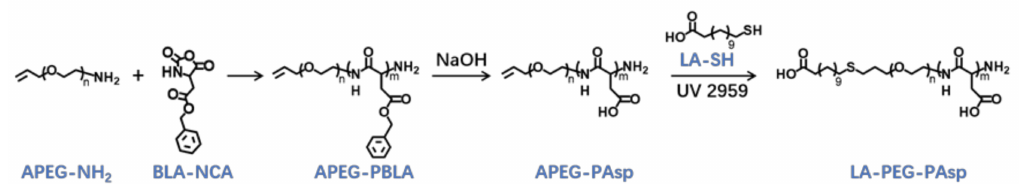
Figure 9. Synthetic route of LA-PEG-PAsp and